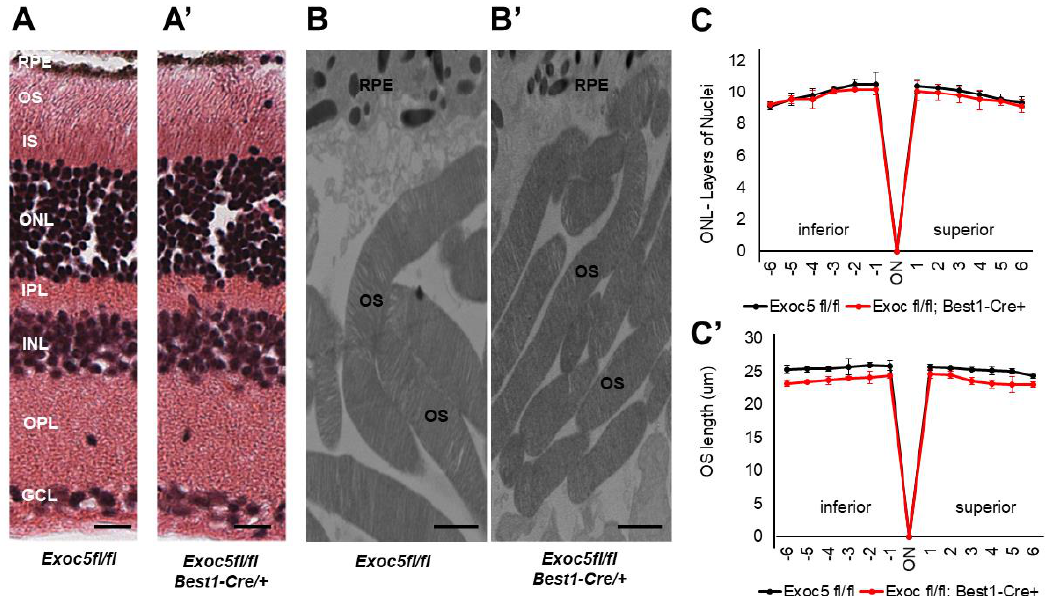
Figure 4. Histological and TEM analysis of retinas of Exoc5 −/− mutants and WT mice at 20 weeks of age. ( A , A’ ) H&E staining of WT and Exoc5 −/− retinas at 20 weeks did not reveal histological differences. ( B , B’ ) Transmission electron microscopy of wild-type (WT) mice photoreceptor cells show that rod OSs are shorter and thinner in Exoc5 −/− retinas. The thickness of the ONL ( C ) and OS lengths ( C’ ) from H&E sections through the optic nerve (ON; 0 μ m distance from Optic Nerve and the starting point) was measured at 12 locations around the retina, six each in the superior and inferior hemispheres, each equally at 150 μ m distances. ( B, B’ ) Scale bars = 800 nm. OS, outer segments; RPE, retinal pigmented epithelium; IS, inner segments; ONL, outer nuclear layer; INL, inner nuclear layer; OPL, outer plexiform layer.